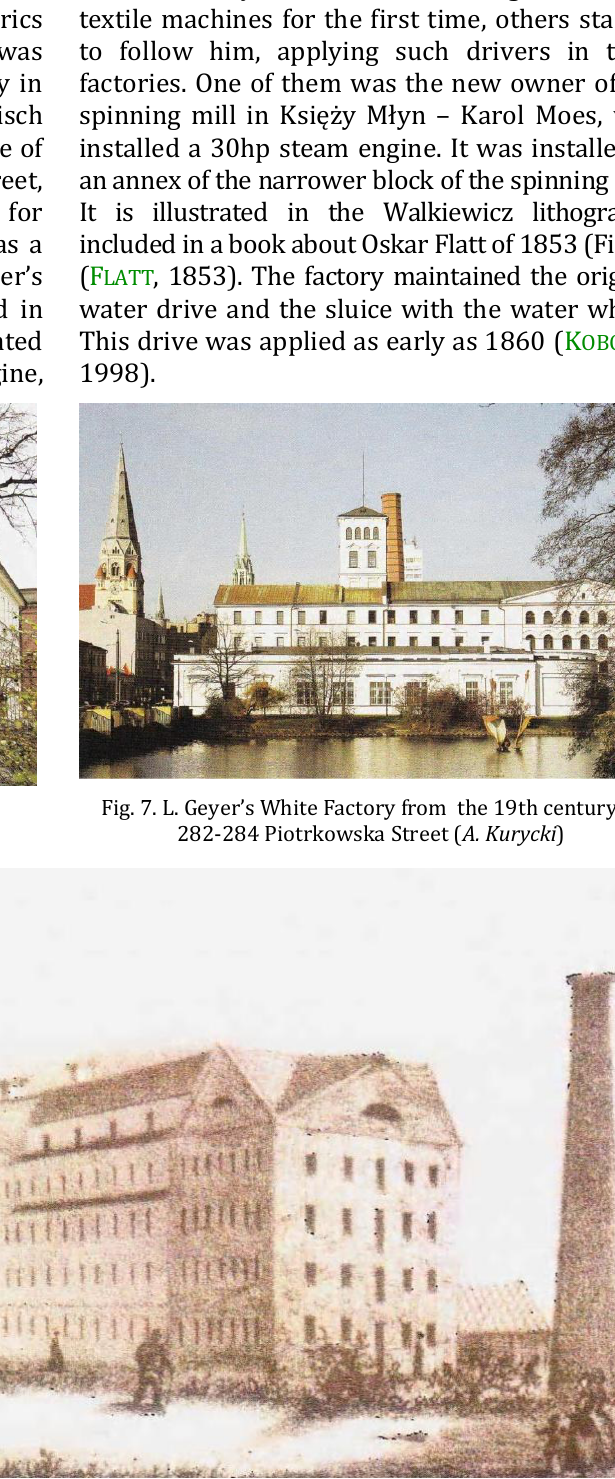
Fig. 8. F.K. Moes factory. W. Walkiewicz lithography (source: Flatt,